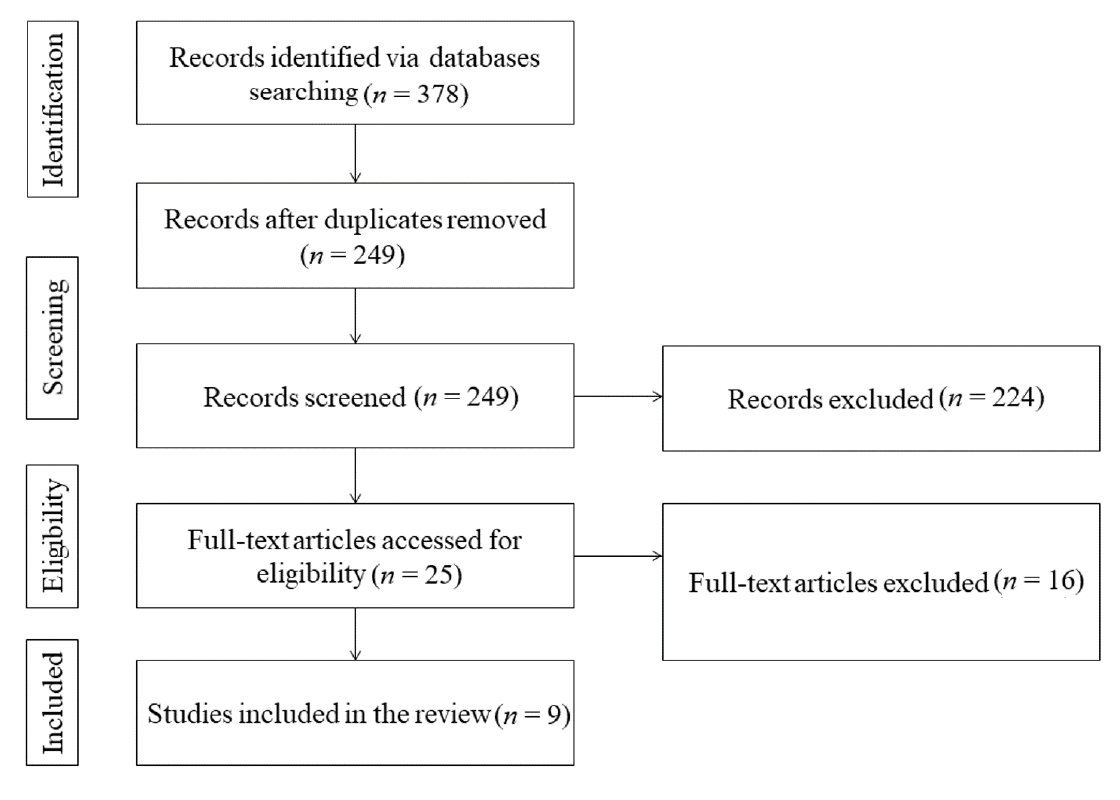
Figure 1. PRISMA flow diagram.